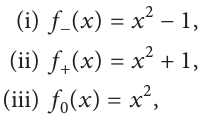
Figure 7: Graphics of 𝑀 1.0,𝑓